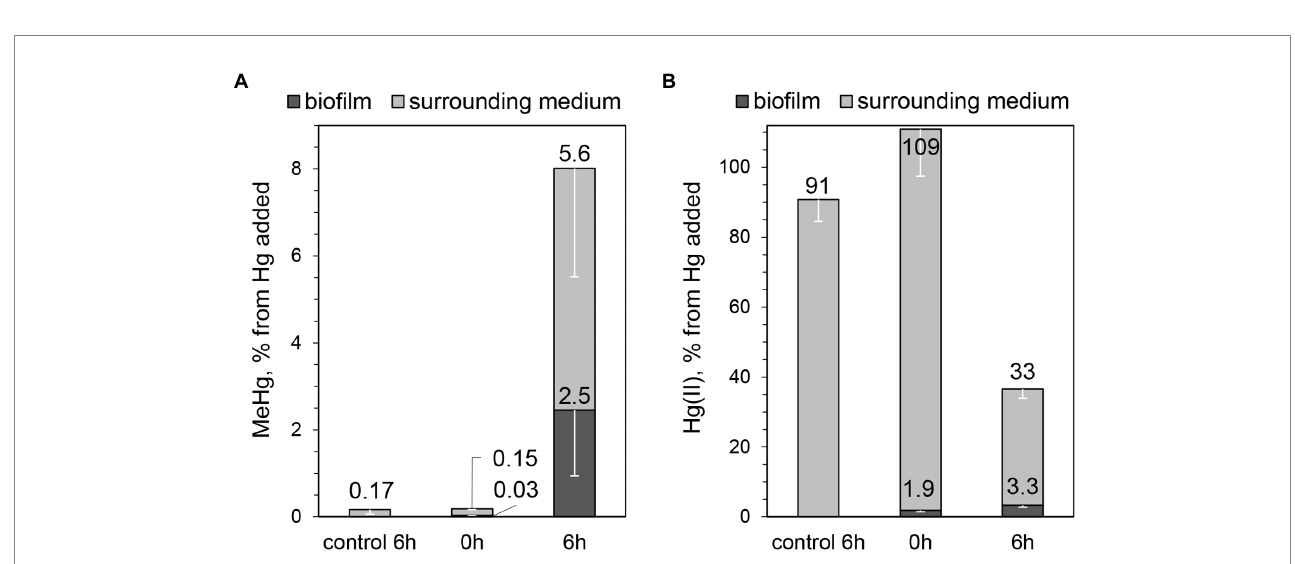
FIGURE 4 Percentage of (A) MeHg produced from 100 nM added Hg, determined in biofilms and surrounding media, after 0 or 6 h of incubation with G. sulfurreducens biofilms grown for 3 days in standard nutritive medium amended with vitamins mixture, and (B) Hg(II) present in biofilms and surrounding media at the same assays. Error bars indicate standard deviation obtained from three